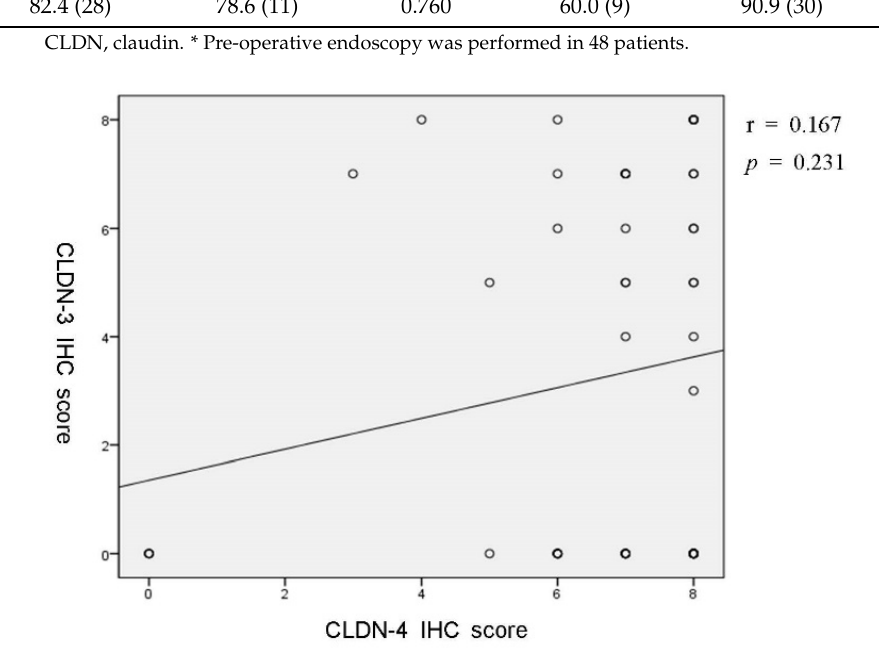
Figure 2. Correlation between CLDN-3 IHC score and CLDN-4 IHC score. CLDN, claudin; IHC, immunohistochemistry.